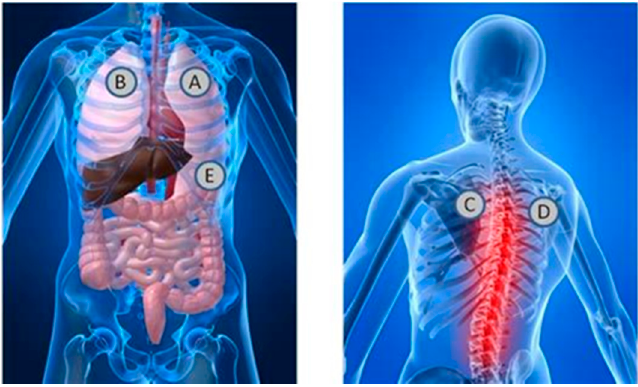
Figure 2. Overview of Stethoscope placement locations.